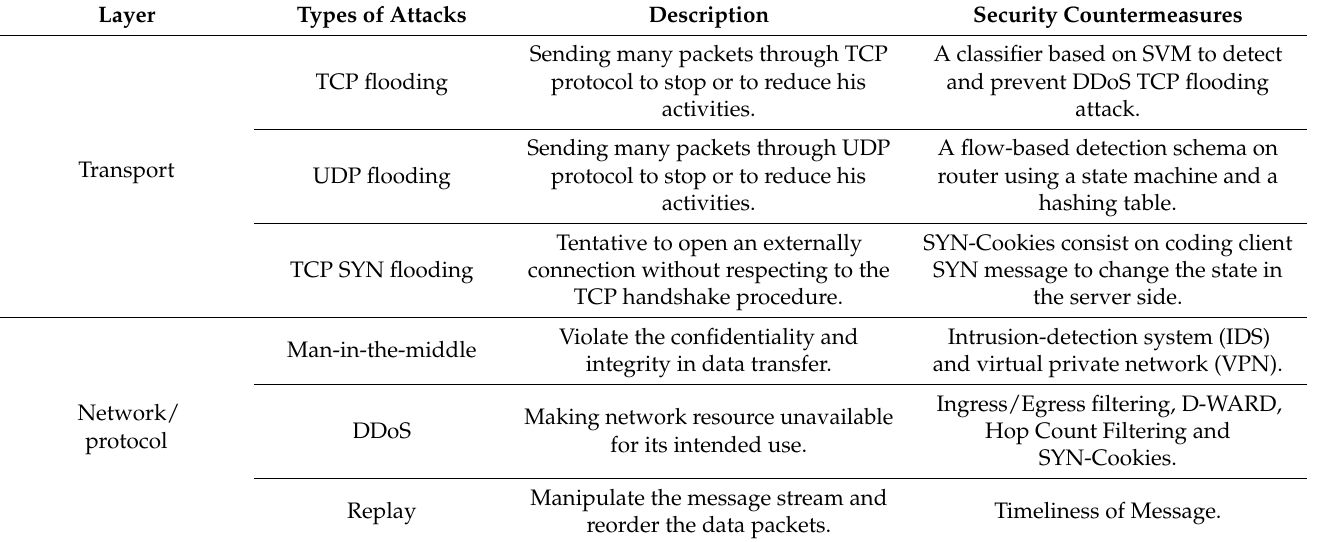
Table 8. The attack and countermeasures on support